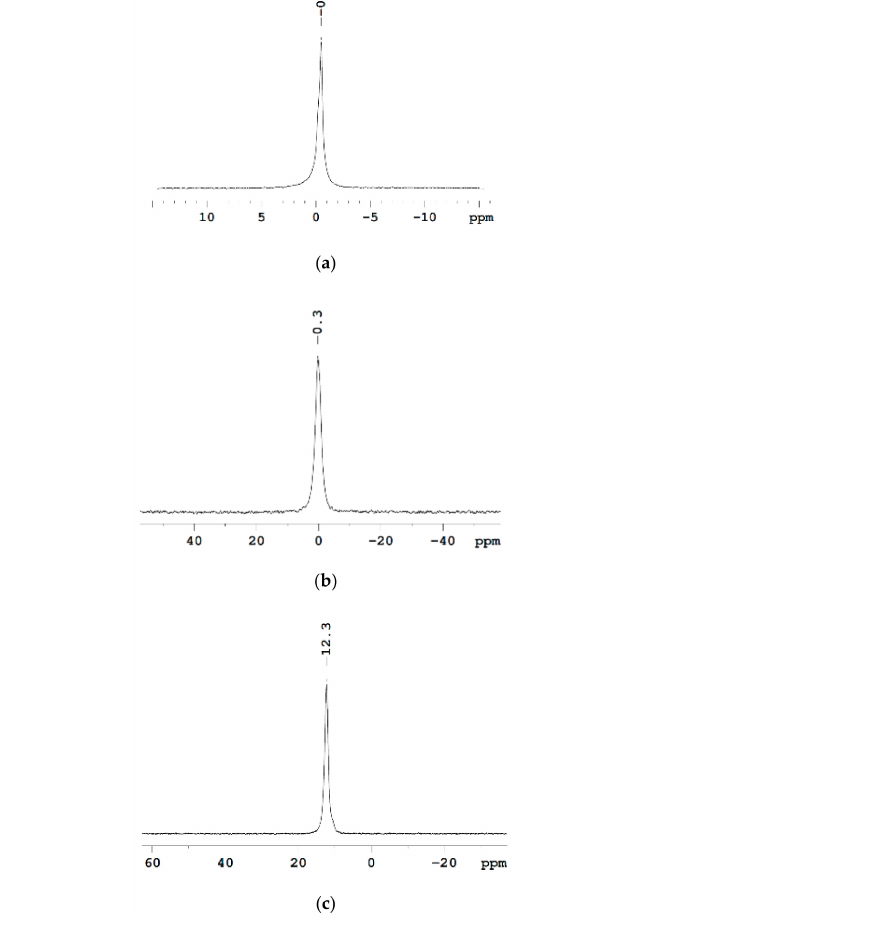
Figure 13. NMR spectra of 7 Li ( a ), 2 3 Na ( b ), and 133 Cs ( c ) nuclei in appropriate ionic form of MSC membrane at RH = 95%